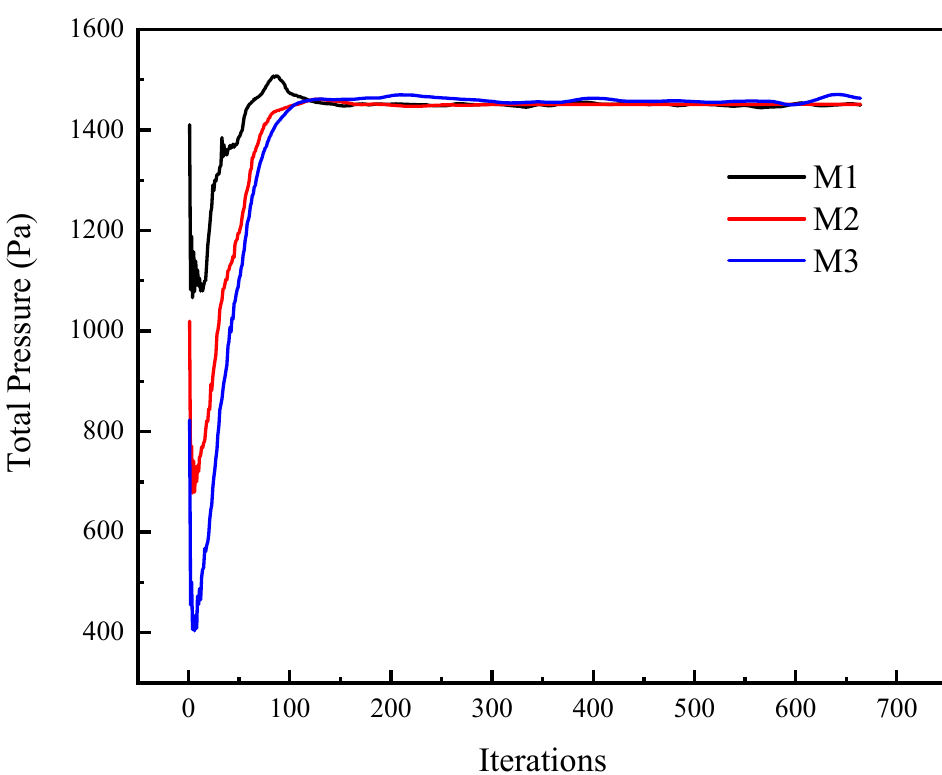
Figure 4. Plot of total outlet pressure with iteration time (V = 2.6 m/s, P s = 129.45 mm, P l = 560 mm). Table 2. Validation results of grid independence.